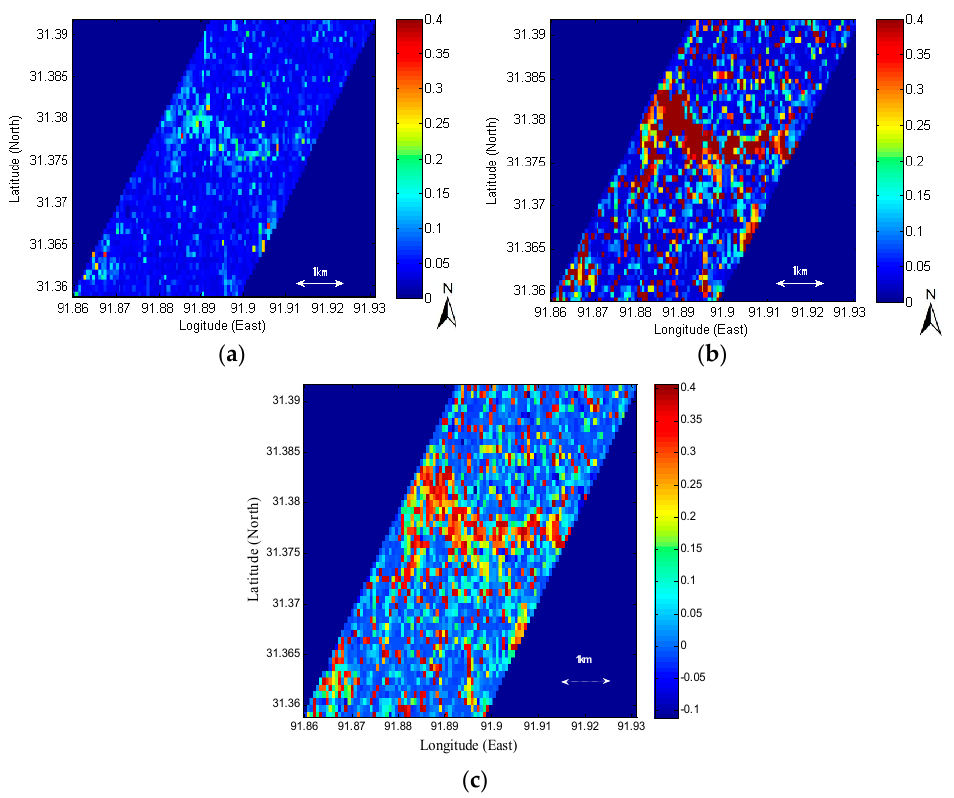
Figure 6. Surface soil moisture (m 3 /m 3 ) on DoY 224: ( a ) Calibrated SVAT land surface model; ( b ) SAR data; and ( c ) difference between (a) and (b).